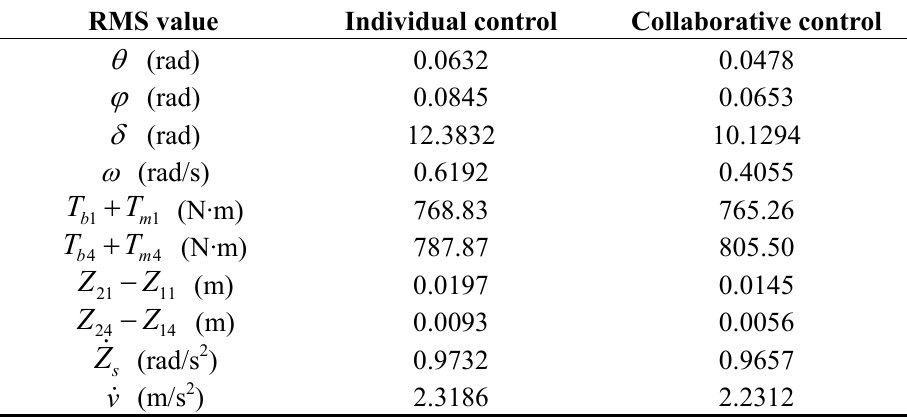
Table 2. A RMS analysis on the vehicle performance